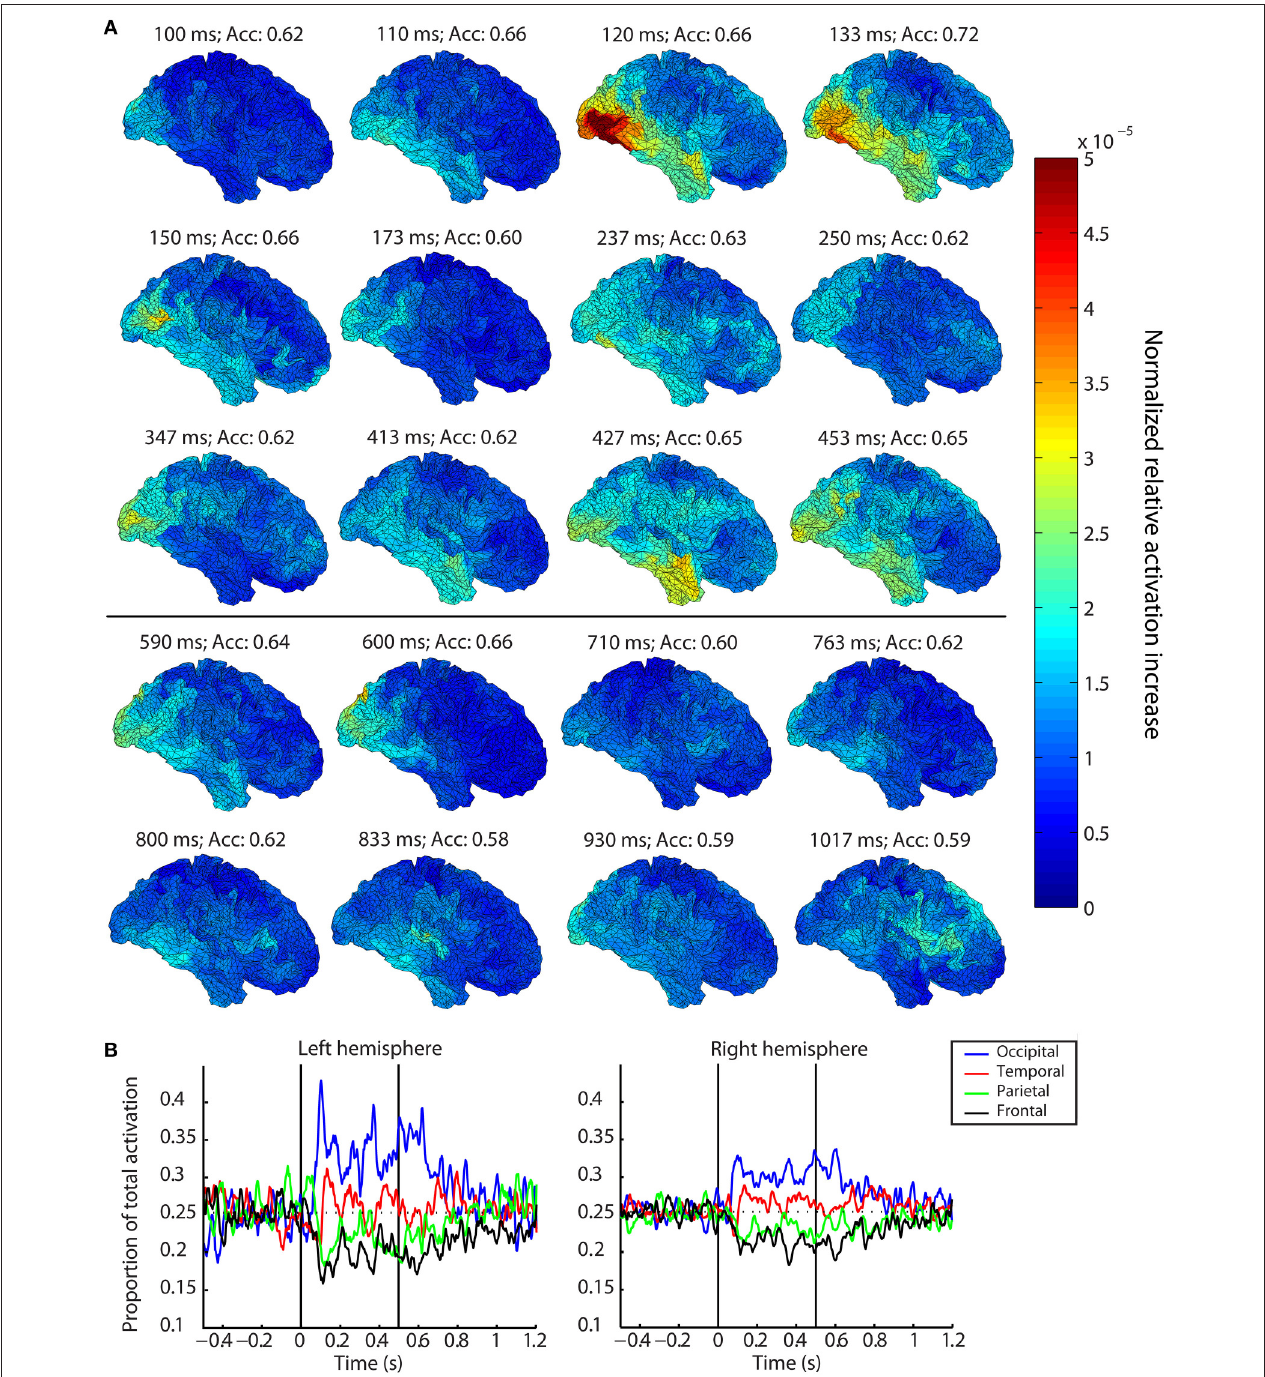
FIGURE 2 | Spatiotemporal dynamics of visual perception. (A) Localization of activation patterns at selected time points for the right hemisphere averaged over subjects. Warmer colors indicate a larger average normalized relative increase in activation compared to baseline. Areas with large values contain information about the identity of the perceived or remembered stimulus. Figures above the black horizontal line correspond to time points during stimulus presentation, figures below this line belong to time points after stimulus offset. (B) Smoothed traces of the proportion of total averaged normalized relative activation originating from each lobe over time. The first black vertical line indicates stimulus onset, the second line coincides with stimulus offset. The horizontal dashed line indicates 0.25, which indicates an equal distribution of activation for the four lobes.